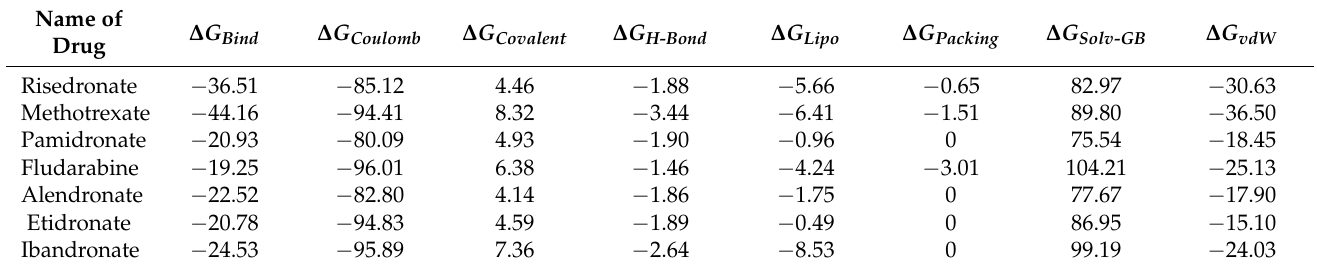
Table 2. Molecular mechanics/generalized Born surface area (MM/GBSA) of drugs showing lower docking energies ( ≤− 8.0 kcal mol − 1 ) in XP docking.